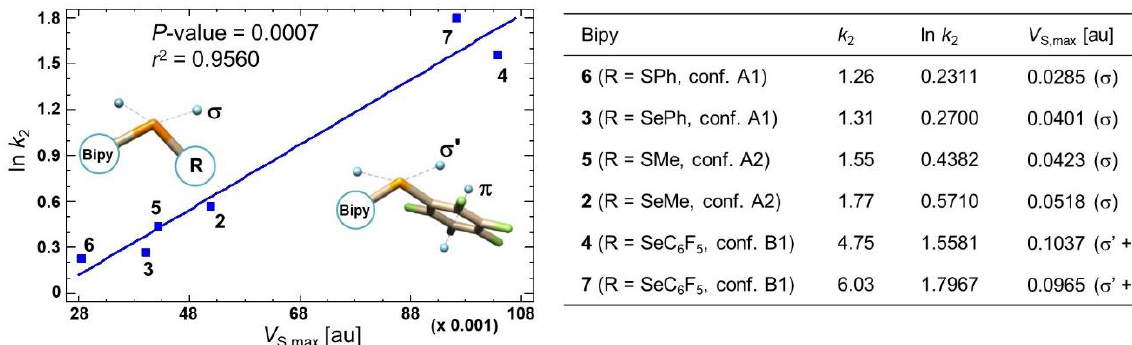
Figure 7. Linear regression analysis describing the relationships between ln k 2 (C-3,5diMe, Hex/IPA 90:10) and V S,max values for compounds 2 – 7 .